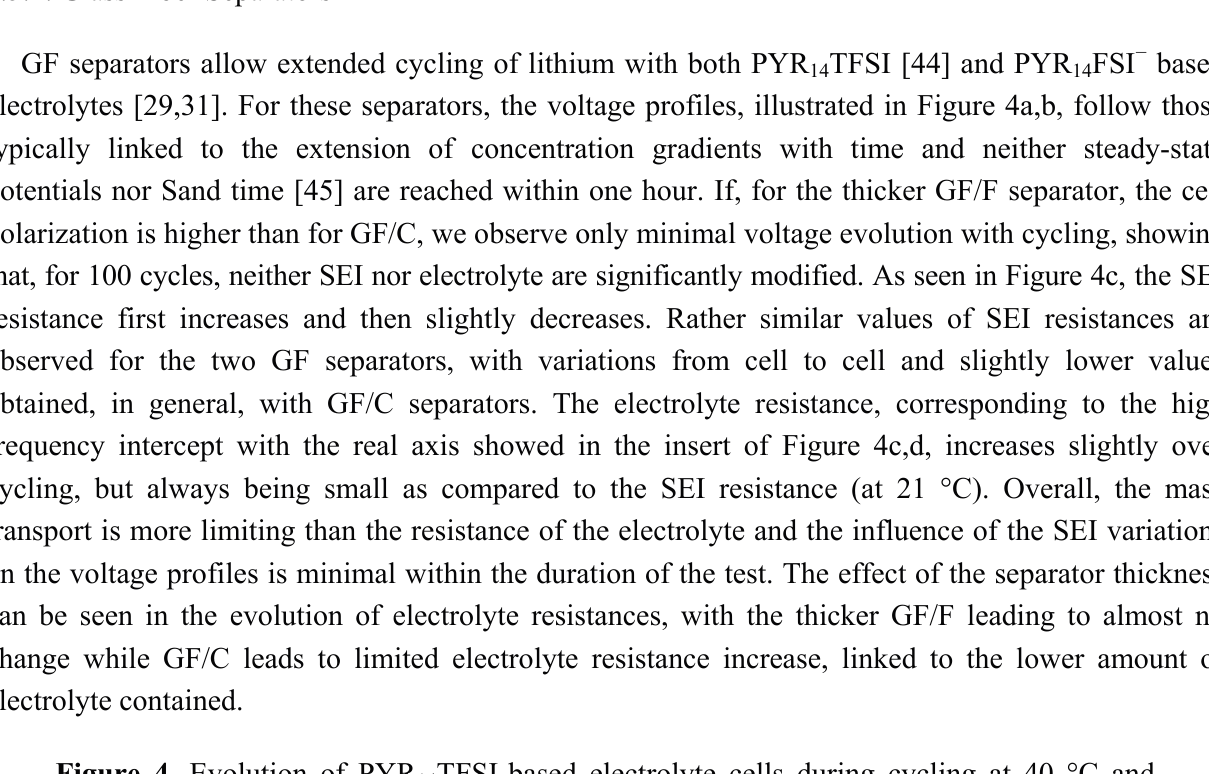
TFSI-based electrolyte cells during cycling at 40 °C and Figure 4. Evolution of PYR 14 0.1 mA·cm − 2 ( a ) Voltage profiles of a GF/F cell; ( b ) Voltage profile of a GF/C cell; ( c ) Evolution of the impedance spectra at 21 °C of a GF/F cell; and ( d ) Evolution of the impedance spectra at 21 °C of a GF/C